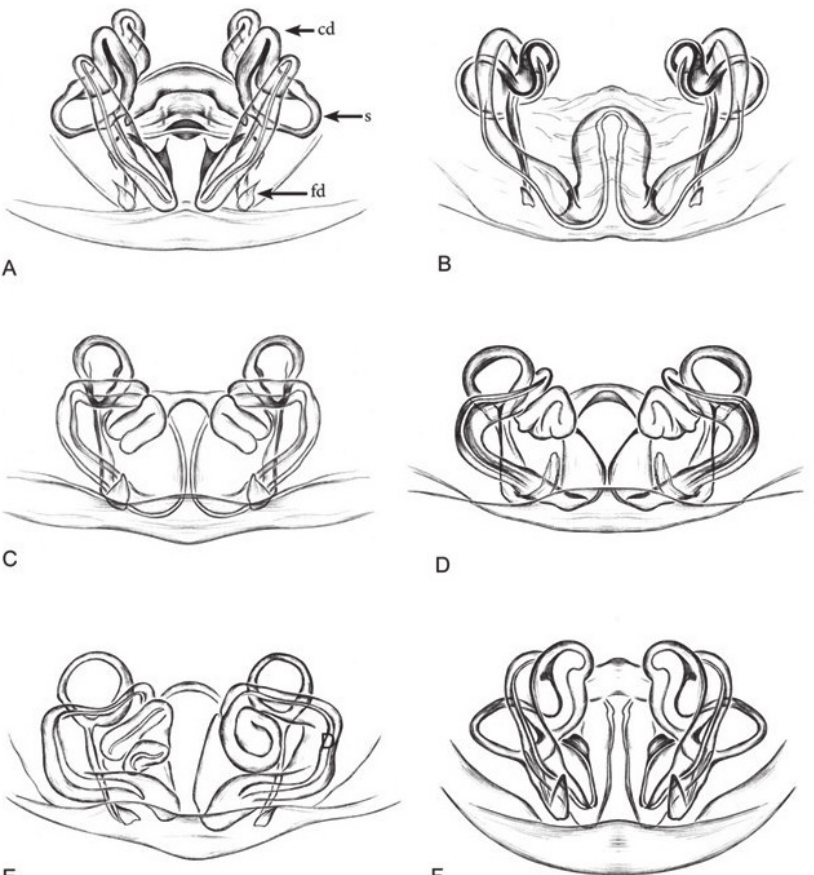
Figure 20. Internal female genitalia, dorsal view. A, Oxyopes amoenus L. Koch, 1878 ( ZMH- A0000003 ) ; B , Oxyopes